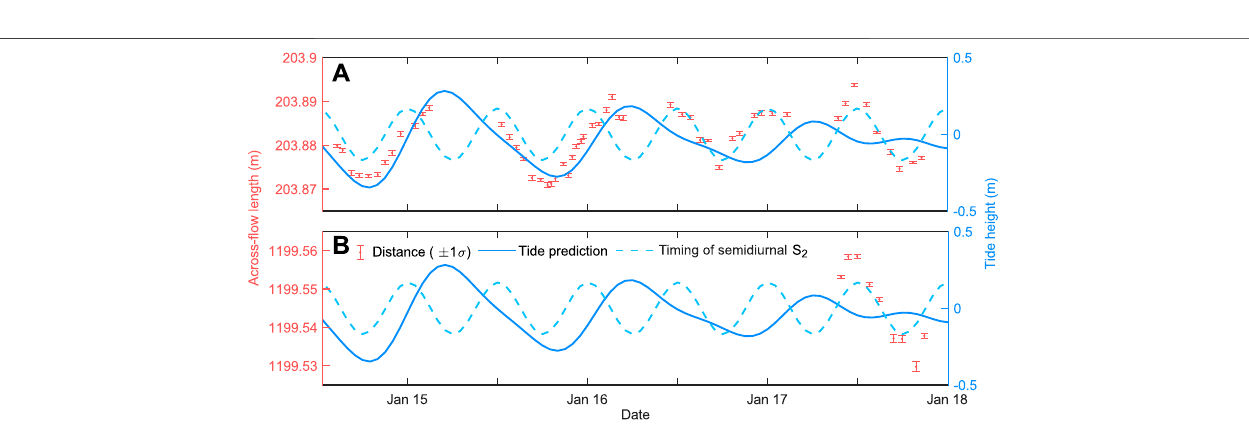
FIGURE 6 | Total station slope-distance observations of an across- fl ow line. Panels (A) and (B) are the 200 and 1,200 m across-glacier surveying transects, respectively. Error bars (1 σ ) are computed from 15 repeated measurements of stake position. Time variation in the slope-distance across the margin is a measure of the tidally-induced ice